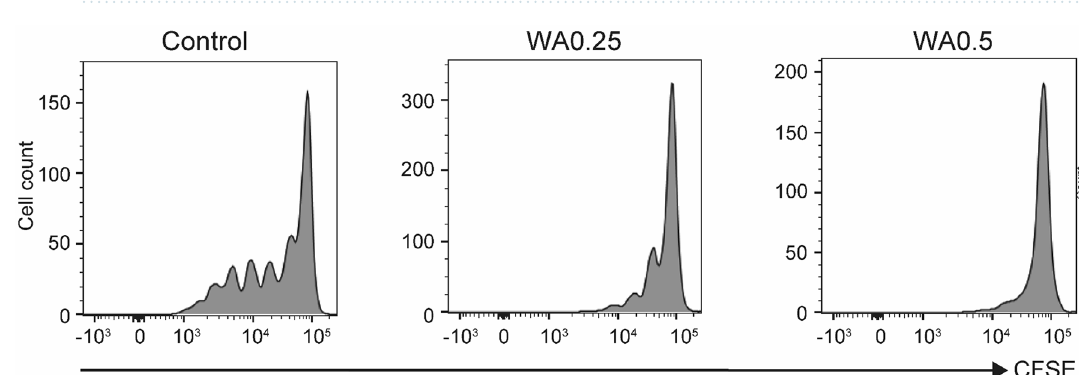
Figure 3. Effects of WA on human T-cell proliferation. Human PBMCs were isolated from the peripheral blood of healthy adult donors and stimulated by CD3/CD28 beads with or without WA 0.25 μg/mL (WA0.25) or WA 0.5 μg/mL (WA0.5) treatment. After 5 days of culture, CD4 + T-cell proliferation was detected by flow cytometry analysis of CFSE-stained cells. Representative histograms from three independent experiments are